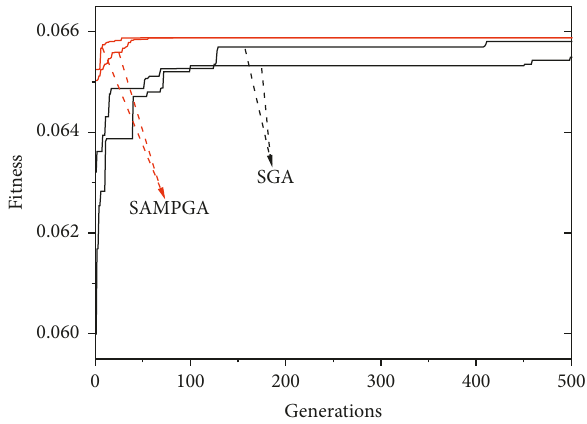
Figure 4: Fitness curves of SGA and